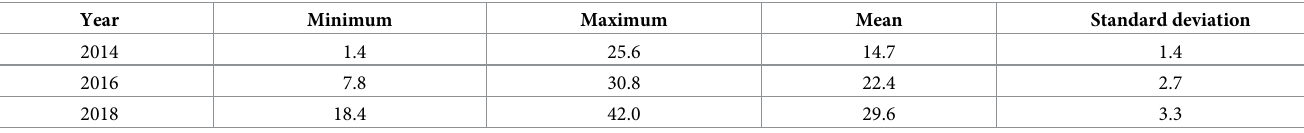
Table 4. Surface temperature statistics (˚C) in each